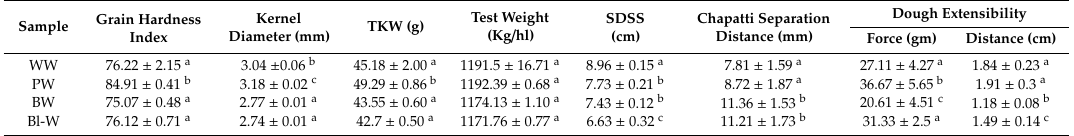
Table 1. Quality parameters of colored